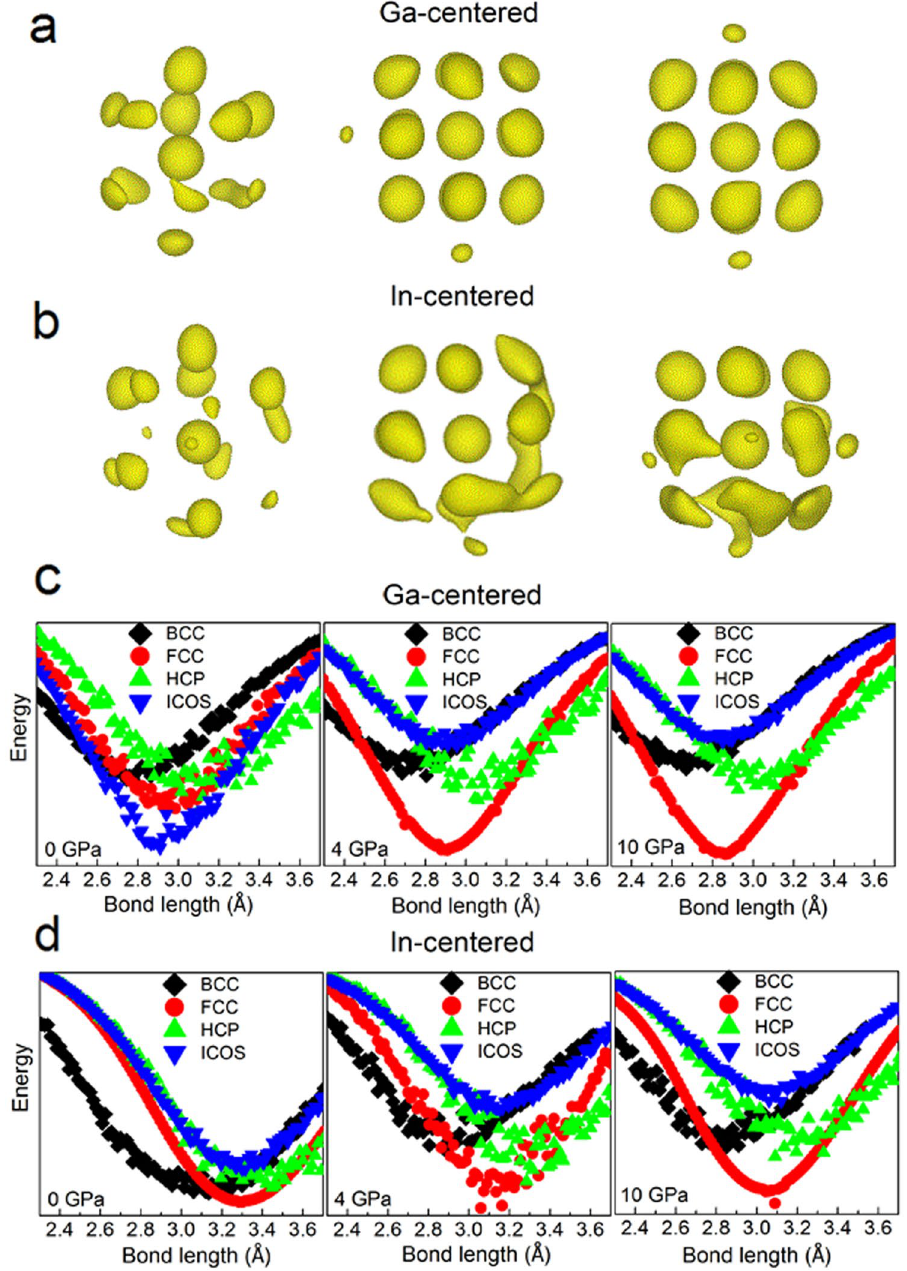
Figure 8. The cluster alignment results of Ga 86 In 14 alloy at selected pressures. ( a , b ) are atomic-density contour plots of final configurations of collective alignment separately for Ga and In-centered local structures, respectively. ( c , d ) are attractive potential energies as the function of bond-length curves for BCC, FCC, HCP, and icosahedral (ICOS) SROs in Ga and In centered clusters,